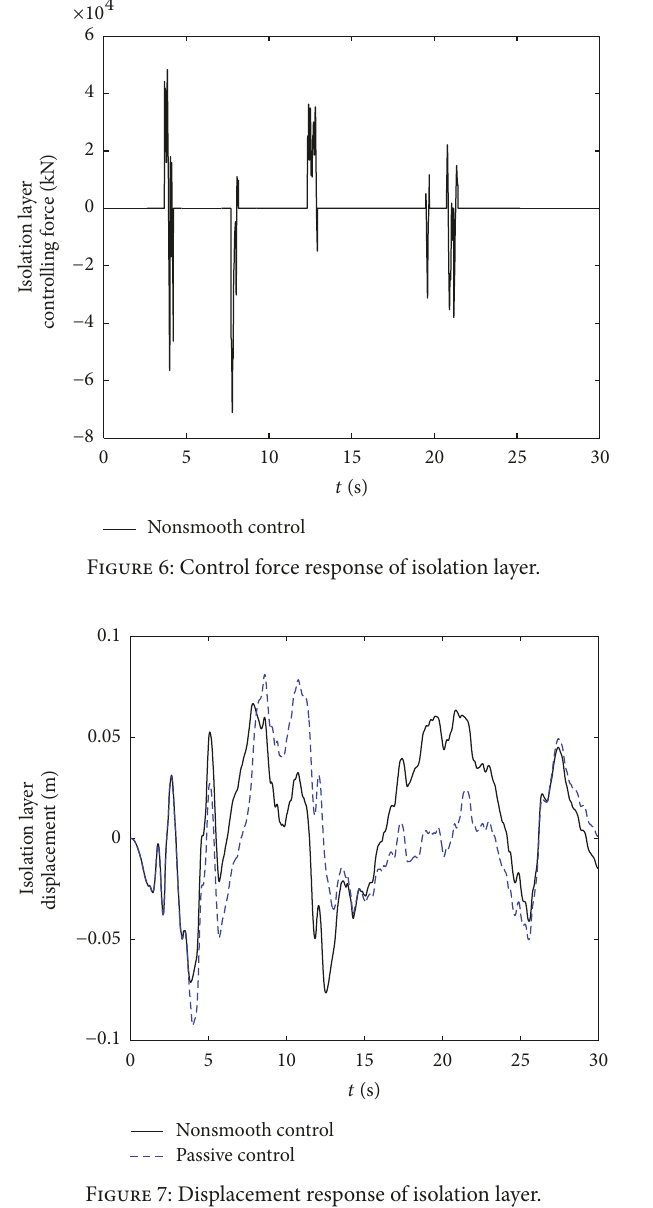
Figure 9: Acceleration response of isolation layer. Table 2: Comparison of peak